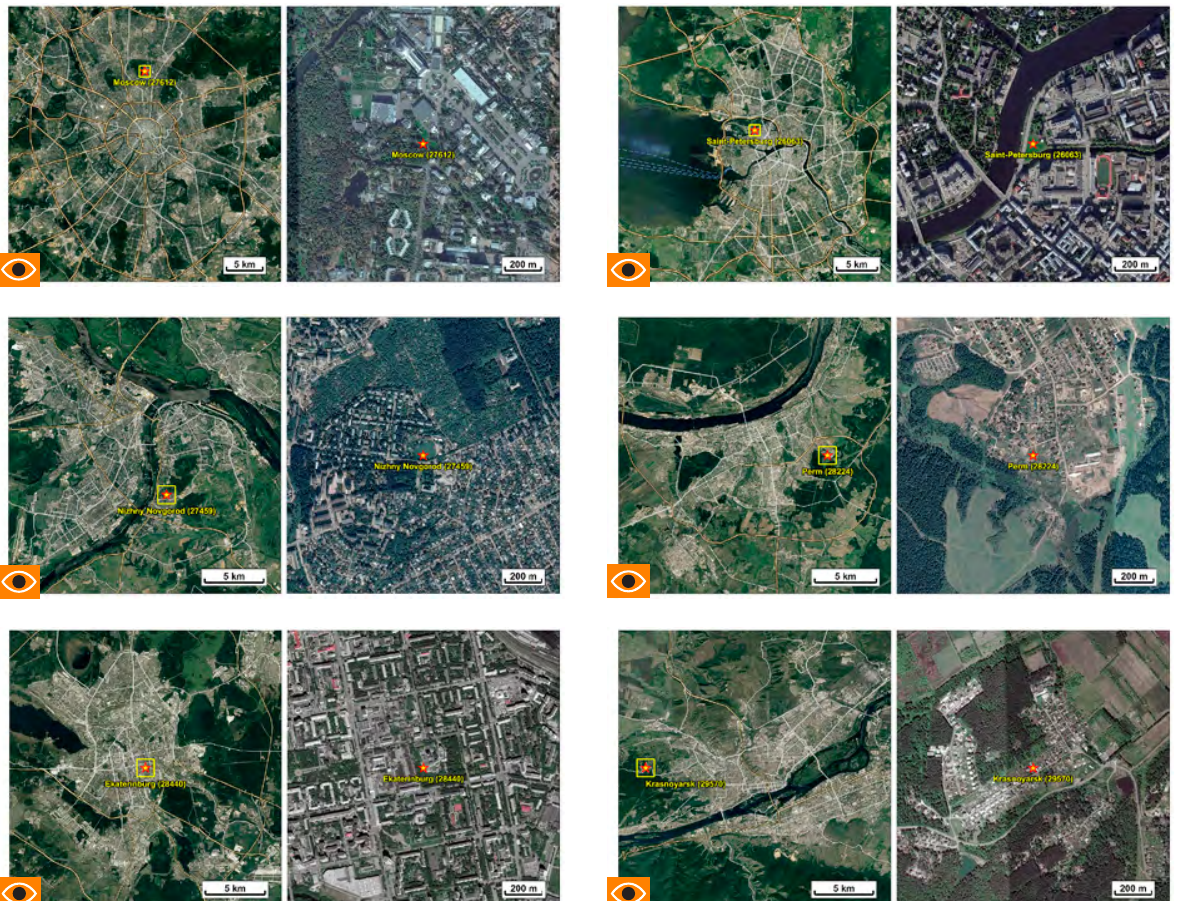
Figure 1. Satellite images of the cities, considered in the study (taken from Google maps) with locations of the used weather stations indicated by asterisk symbols (right panels). Right panees shows satellite images of the nearest surrounding of the weather stations (area within yellows squares in the left panels)